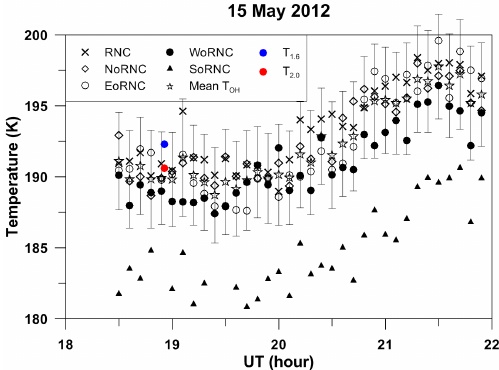
Figure 6. A comparison of ground-based OH temperature and SABER measurements on 15 May 2012. The variation of T OH at RNC, NoRNC, EoRNC, WoRNC, SoRNC and overall mean (ex- cluding the contaminated SoRNC) are presented by “ × ”, “ (cid:5) ”, “ ◦ ”, “ • ”, “ (cid:78) ” and “ (cid:63) ” respectively. The uncertainty in T OH measure- ments is shown by error bars across mean T OH values. Solid circles in blue and red represent SABER OH-equivalent temperatures T 1 . 6 and T 2 . 0